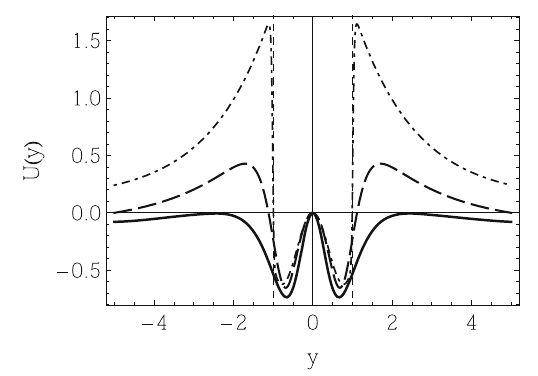
Fig. 11 Numericalplotof U ( y ) for U ( 0 ) = 0, ψ 0 = 1,and ϕ 0 = 1 . 54, with n = 1 (solid line), n = 2 (dashed line) and n = 20 (dot-dashed line)